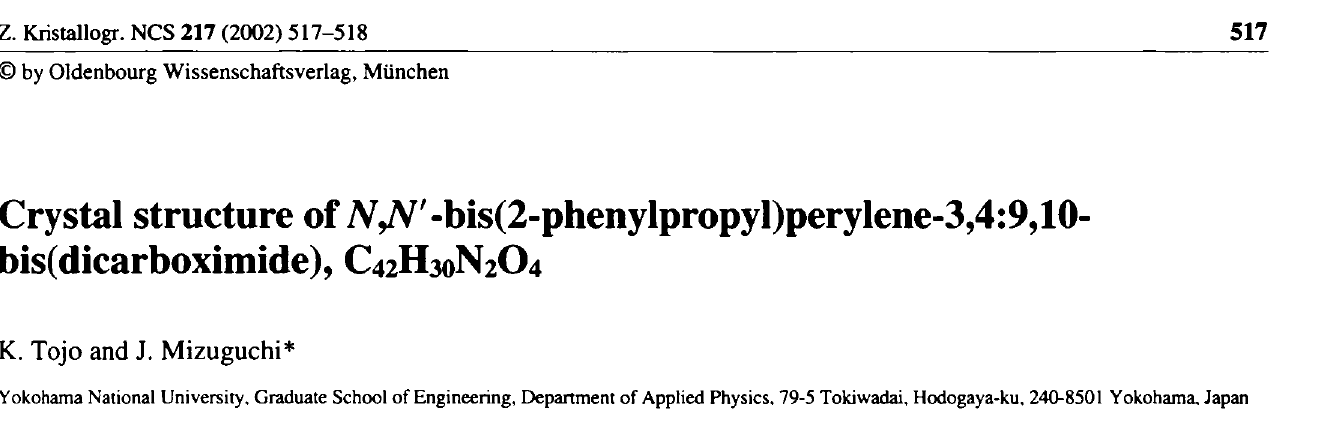
Table 1. Data collection and handling.